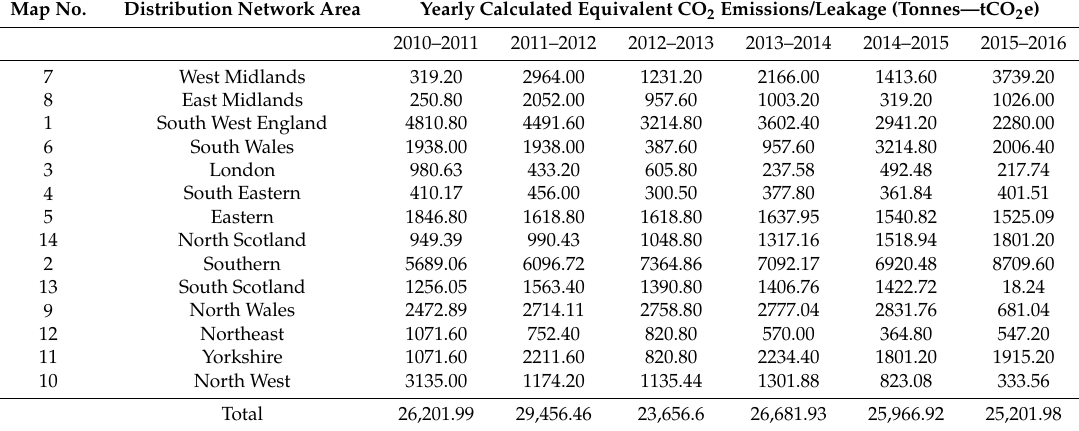
Table 2. Calculated equivalent electricity distribution network area SF 6 emissions (tCO 2 e) (scale factor: 1 kg SF 6 = 22,800 kg CO 2 ). Map No.